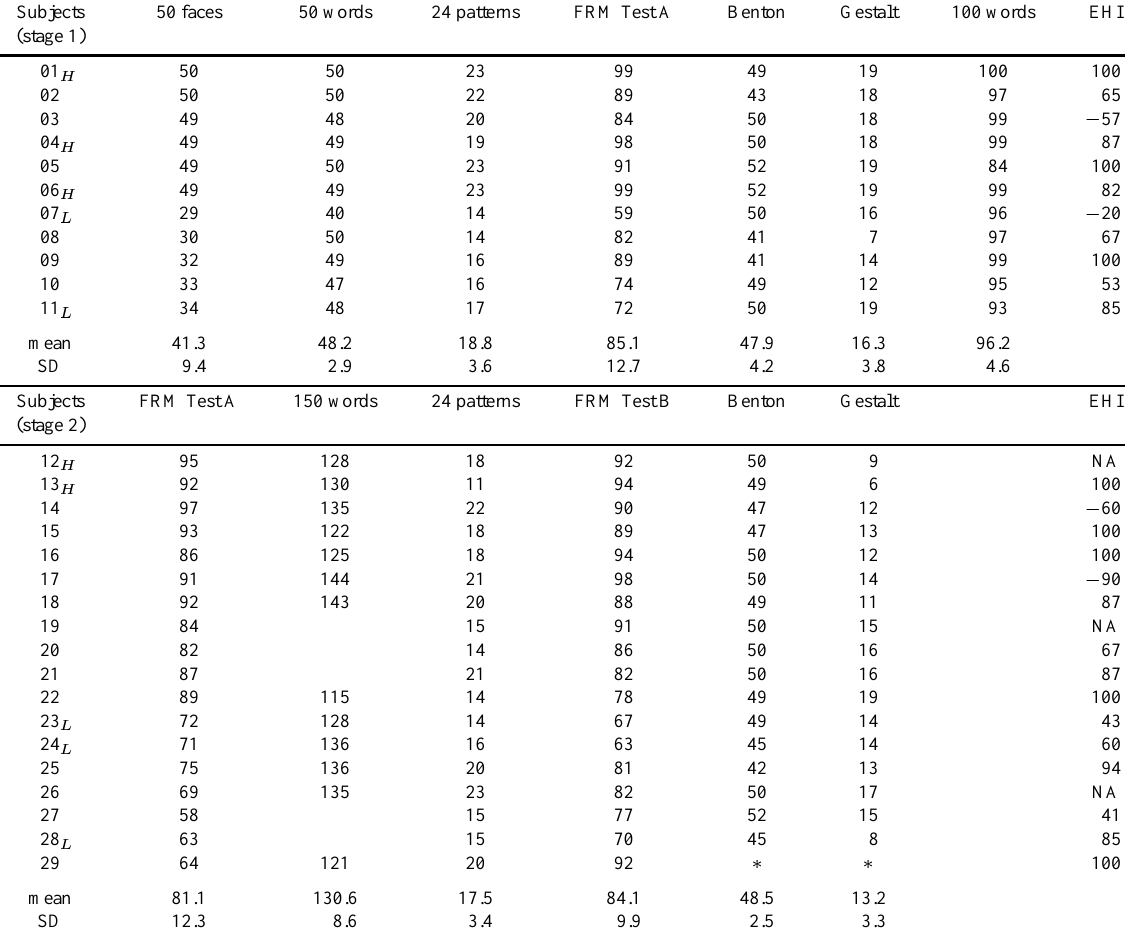
Table 4 Results of the 50 faces, 50 words, 24 patterns, 100 faces, Benton and Gestalt psychometric tests given to the eleven subjects in stage 1